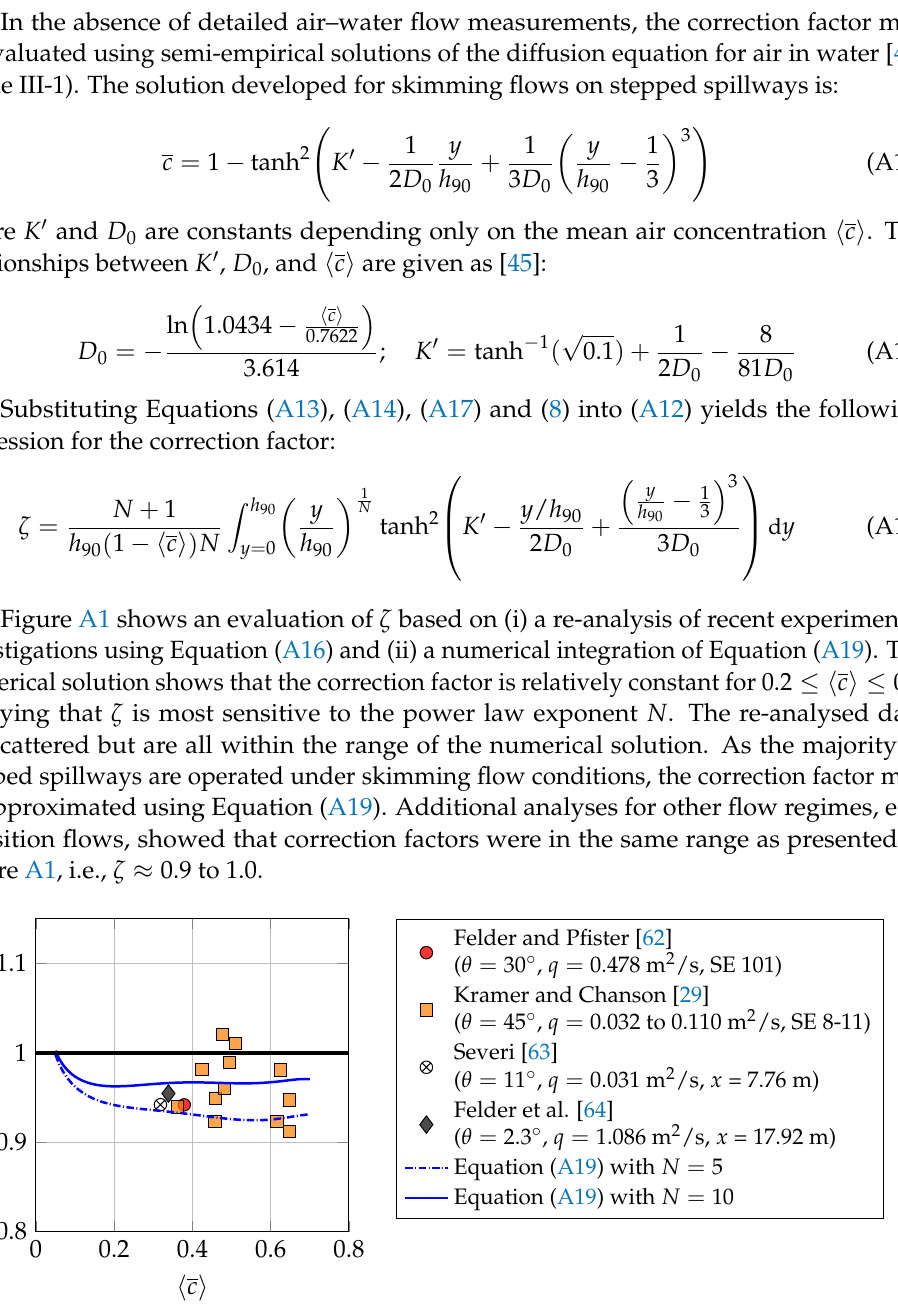
Figure A1. Dependency of the correction factor ζ on the mean air concentration (cid:104) c (cid:105) for selected studies of high-velocity air–water flows on spillways